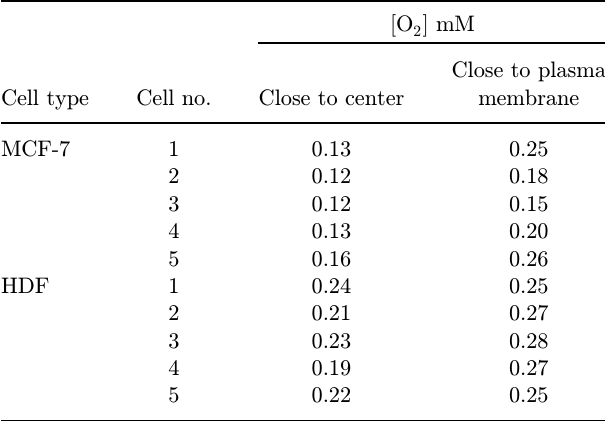
Table 2. Estimation of oxygen concentrations in MCF-7 and HDF cells by the epi-phosphorescence-TCSPC method.